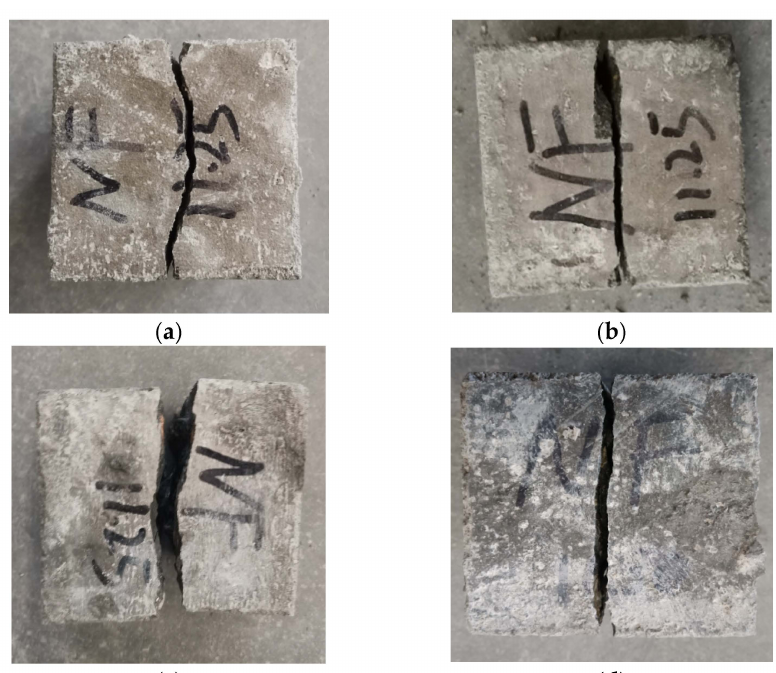
Figure 17. Failure performance of NF specimens with different ages after splitting tensile test: ( a ) 3 d; ( b ) 7 d; ( c ) 14 d; and ( d ) 28